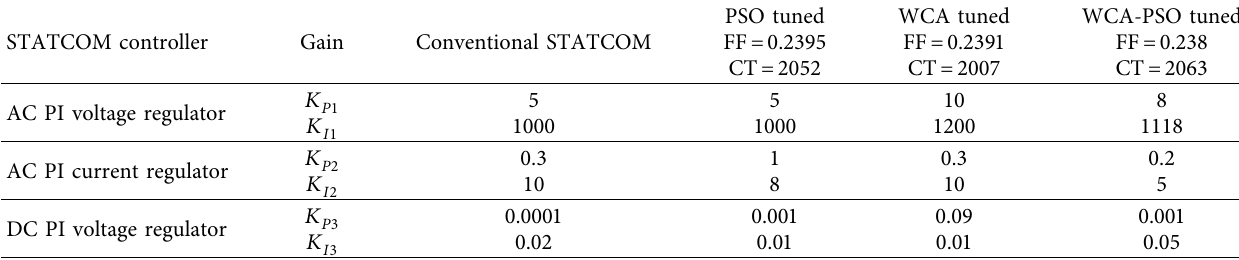
Table 10: PI controller